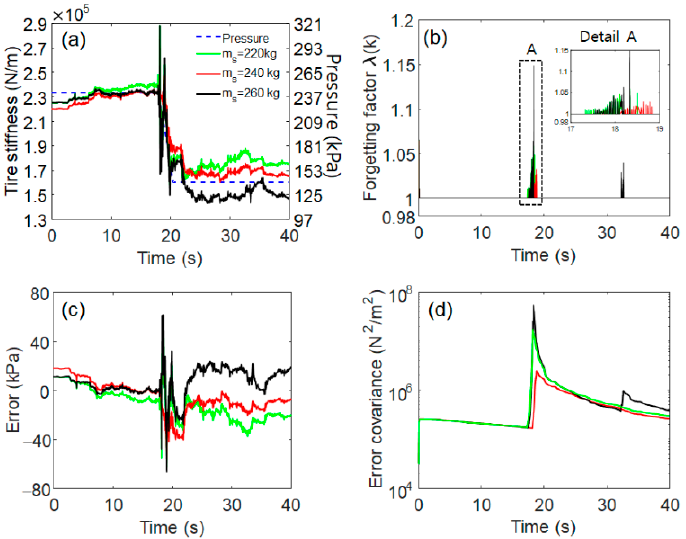
Figure 10. Simulation result of tire stiffness estimation with respect to different sprung masses. ( a ) Tire stiffness response to pressure drop (241.3 kPa → 138 kPa), ( b ) time evolution of the forgetting factor (inset, detail around pressure change), ( c ) estimation error and ( d ) convergence history of error covariance.